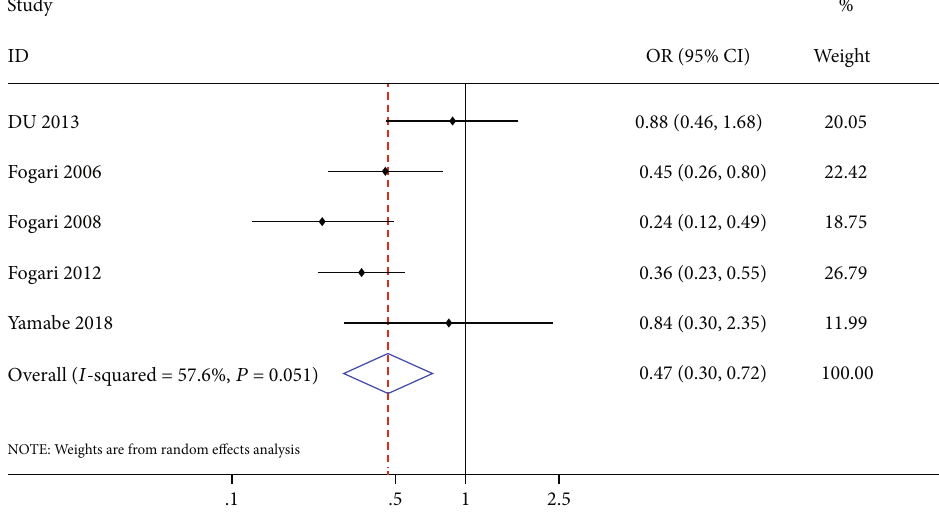
Figure 3: Forest plot of studies assessing the AF recurrence rate among patients with hypertension and AF.